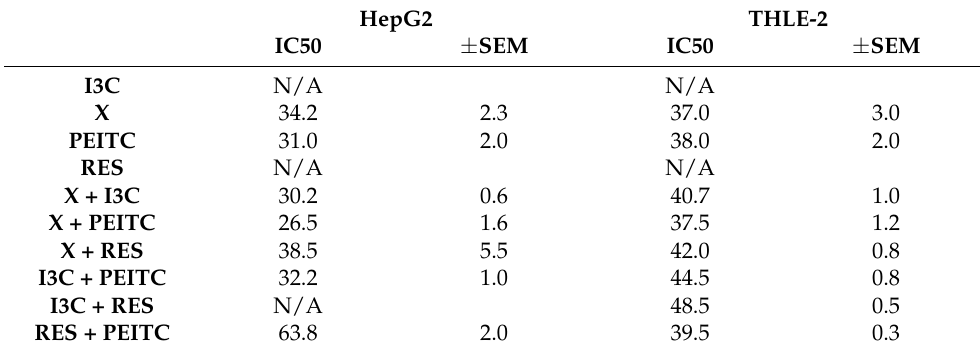
Table 3. The IC50 values for HepG2 and THLE-2 cell